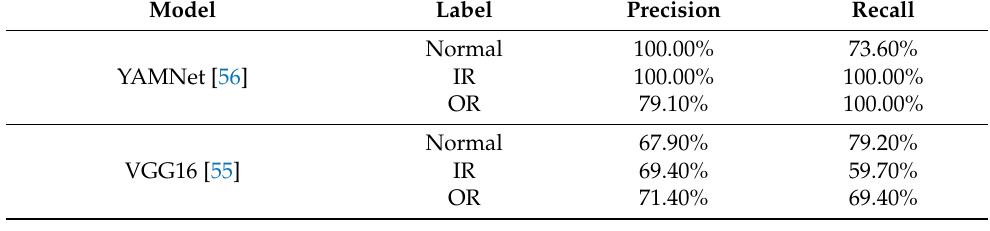
Figure 10. Loss functions.